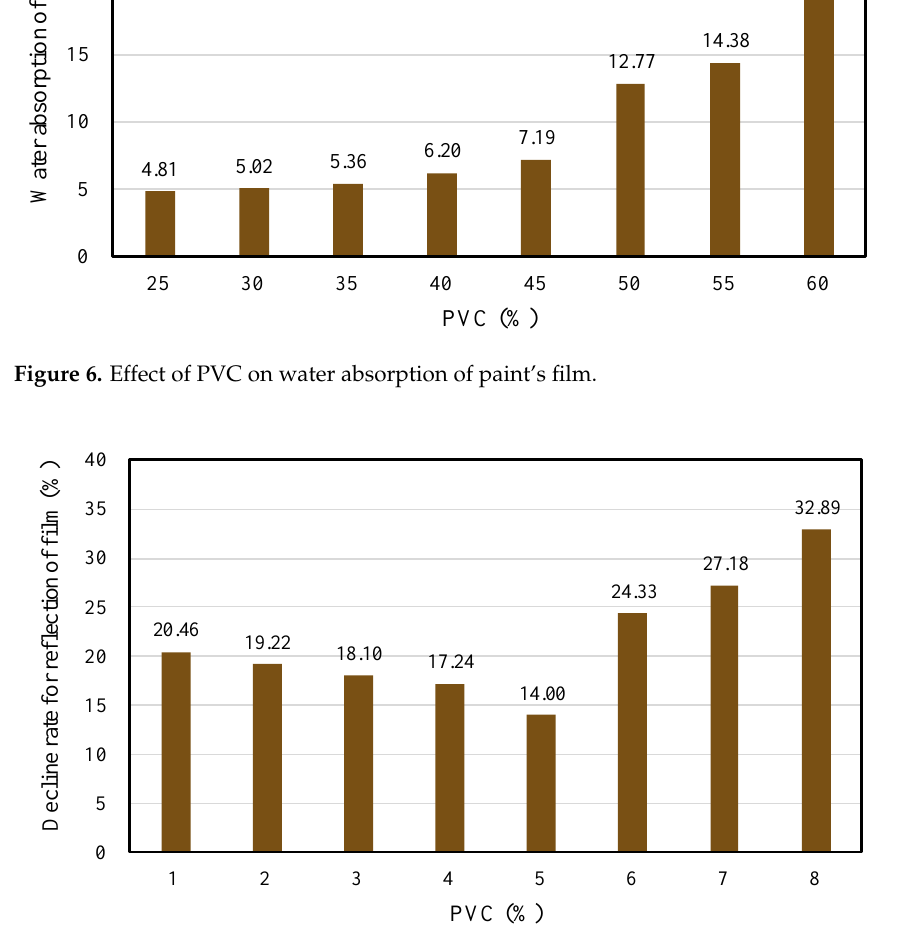
Figure 7. Effect of PVC on decrease rate for reflection of paint’s film.